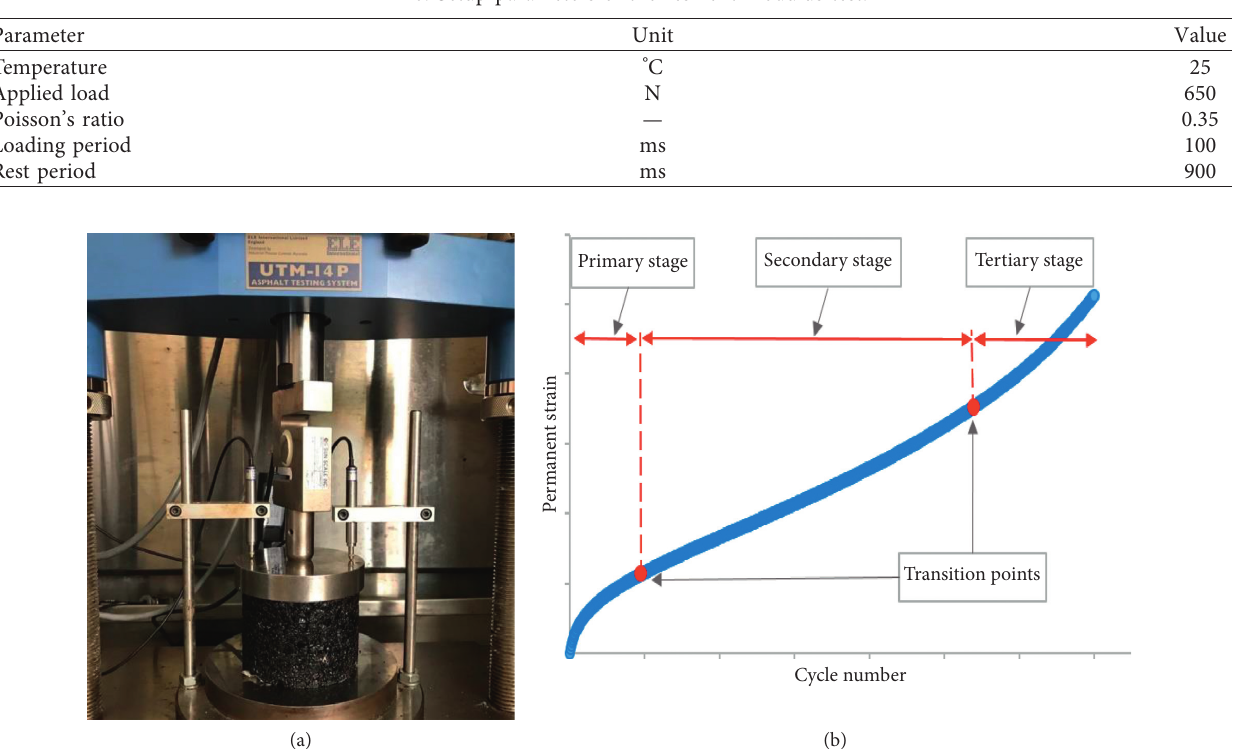
Figure 3: Resilient modulus test: (a) resilient modulus test apparatus and (b) loading shape. Table 6: Setup parameters of the resilient modulus test.